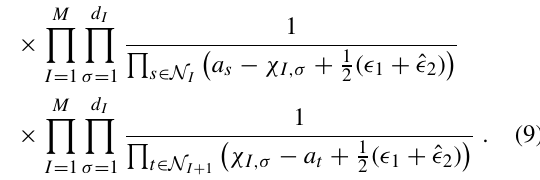
For a surface operator with a Levi subgroup L in a 4d theory with a gauge group G , the relevant sigma model is defined on the target space G / L [2,3]. Such a space is, in general, a flag variety which can be realized as the low-energy limit of a GLSM [13,15], whose gauge and matter content can be summarized in the quiver diagram of Fig.